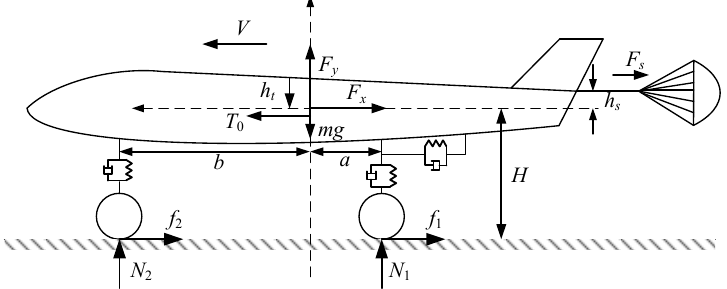
Figure 1. Force diagram of aircraft fuselage. Table 1. Parameters of aircraft fuselage dynamics.